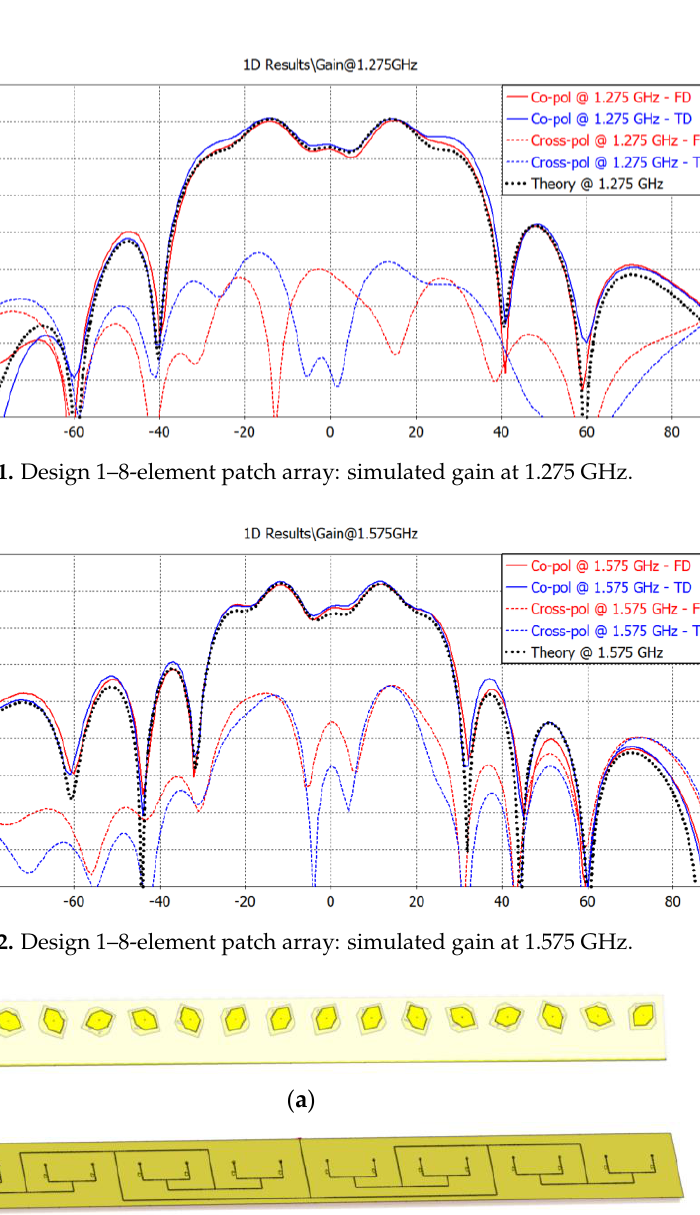
Figure 10. Design 1 – 8-element patch array: simulated reflection coefficient.